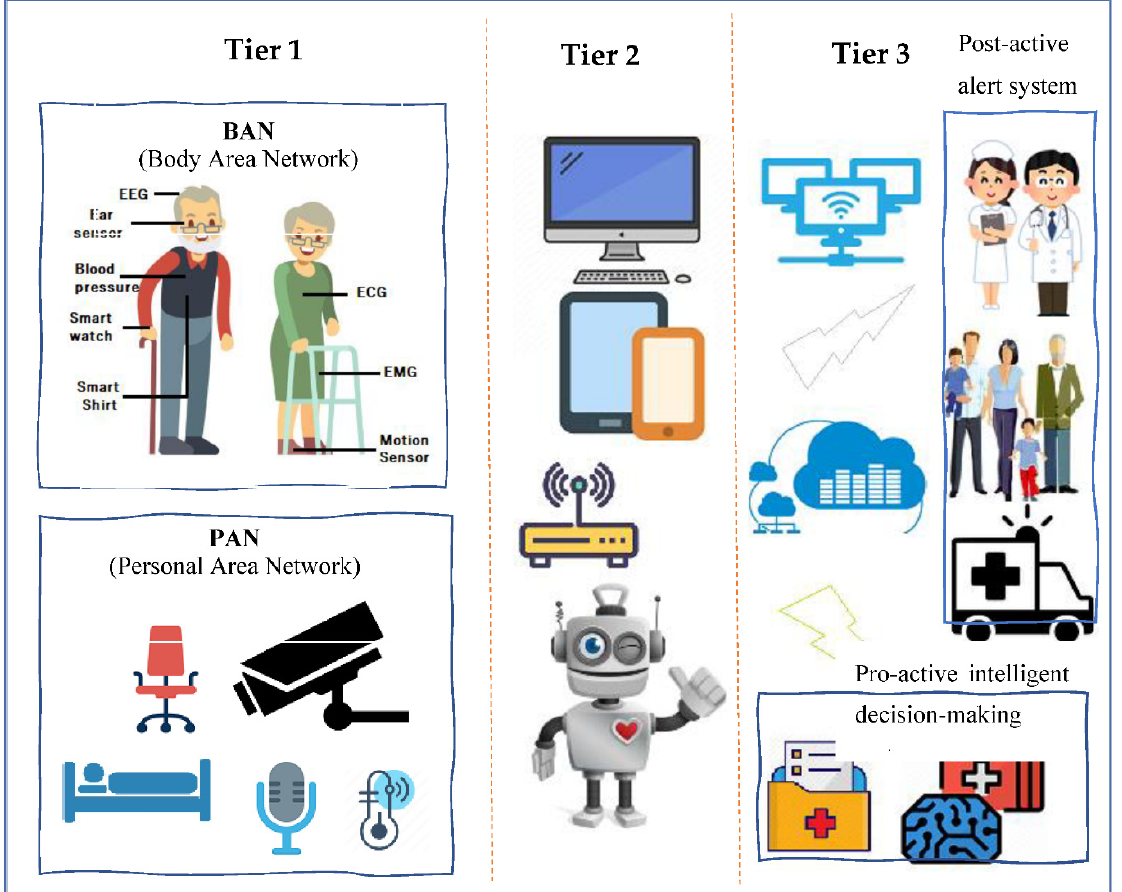
Figure 3. Common healthcare monitoring systems architecture.